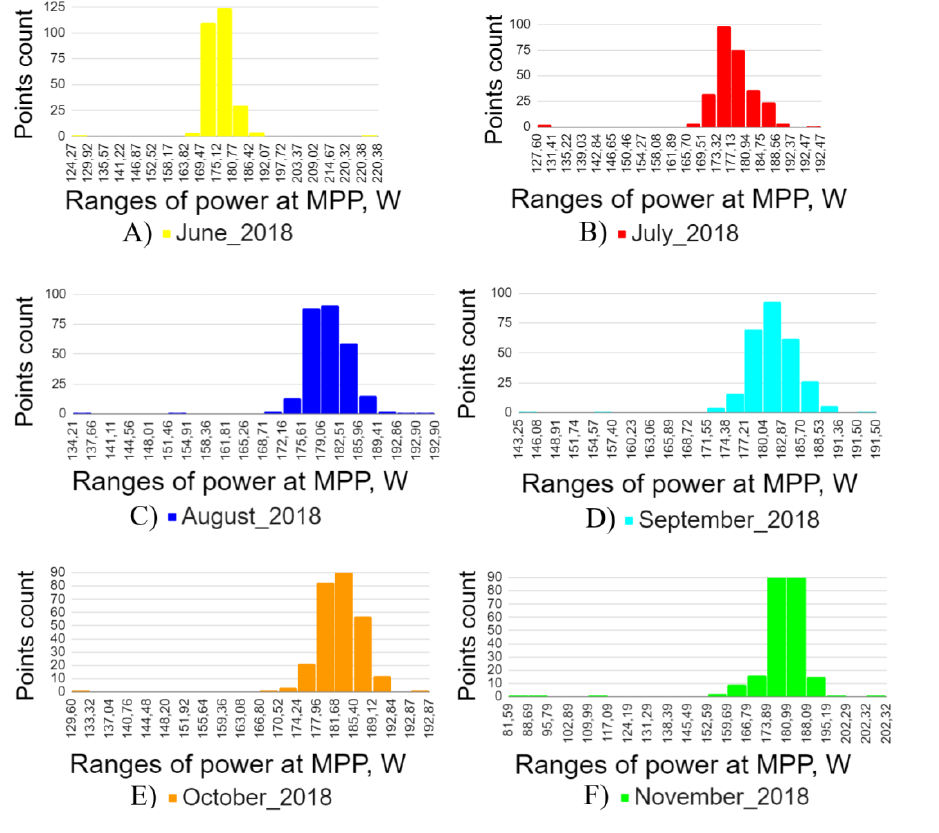
per modules during mpp